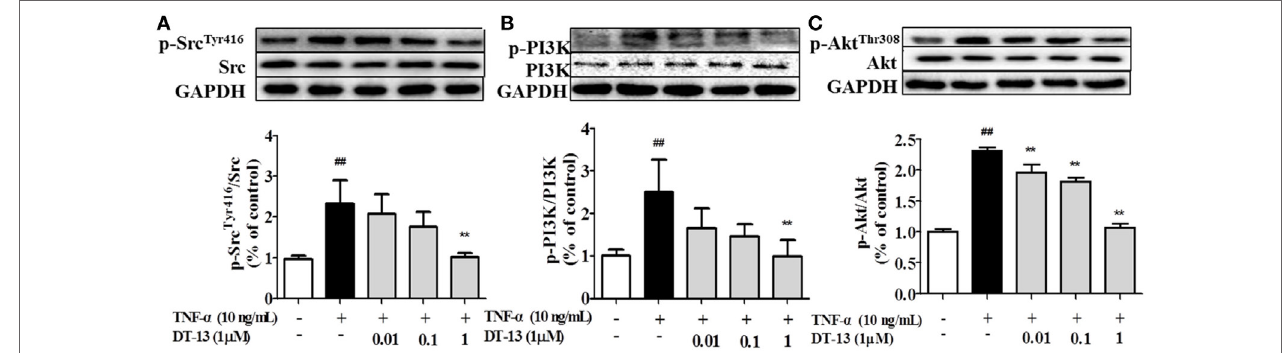
FigUre 3 | DT-13 modulated Src/PI3K/Akt pathway proteins in human umbilical vein endothelial cells (HUVECs). (a) Western blotting analyses of Src, (B) PI3K, and (c) Akt were performed after 4 h of 10 ng/mL TNF- α stimulation with or without various concentrations of DT-13 (0.01, 0.1, 1 µM) pretreatment for 1 h. The blots are representative images from three separate experiments. DT-13 decreased the expression of p-Src, p-PI3K, and p-Akt in HUVECs. The data represent the mean ± SD from three experiments. ## P < 0.01 vs. the control group; ** P < 0.01 vs. the TNF- α